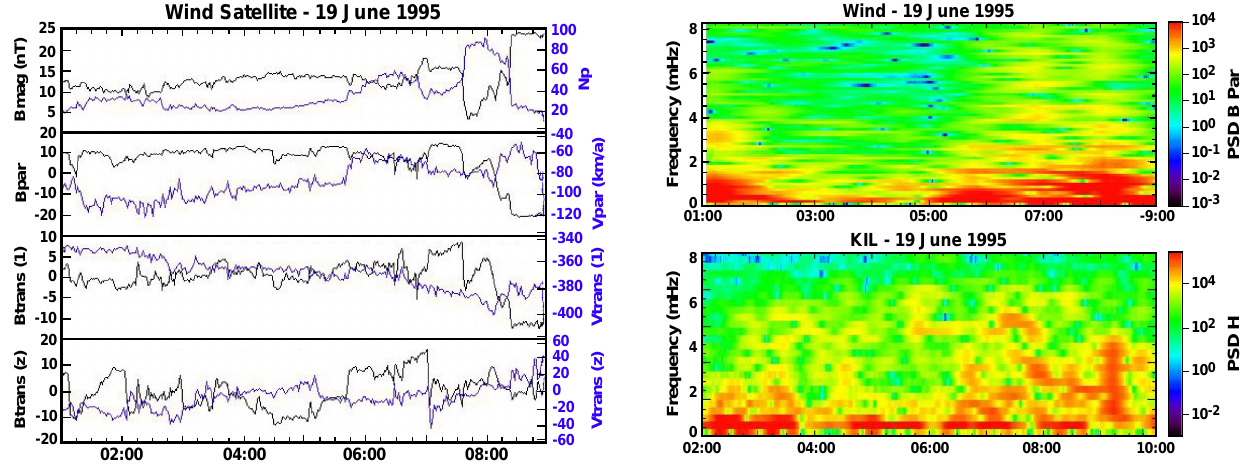
Fig. 11. Wind data in the solar wind inside the compression region, 19 June 1995. Top panel: magnetic field and density; bottom three panels: field-aligned and perpendicular components of b and v . Fig. 12. KIL ground-based data during the time when the com- pression region of a high speed stream impacts the Earth’s magne- tosphere on 19 June 1995. Top panel: magnetic field magnitude; middle panel: H component; bottom panel: D component.